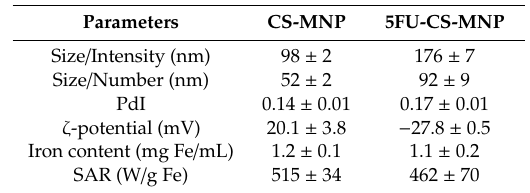
Table 1. Main features of the MNPs used in the present study. CS: Chitosan; 5FU: 5-fluorouracil; MNP: magnetic nanoparticle; PdI: polydispersity index; DLS: dynamic light scattering; AAS: atomic absorption spectrometry; SAR: specific absorption rate. The numbers are reported as mean ± standard deviation, n =